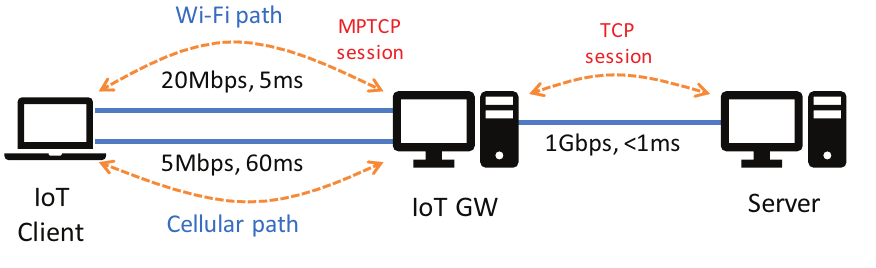
Figure 3. Testbed setup: The IoT client is connected to the IoT gateway (GW) via two emulated paths, i.e., Wi-Fi path and Cellular path, by MPTCP. The IoT GW is connected to the server via a TCP